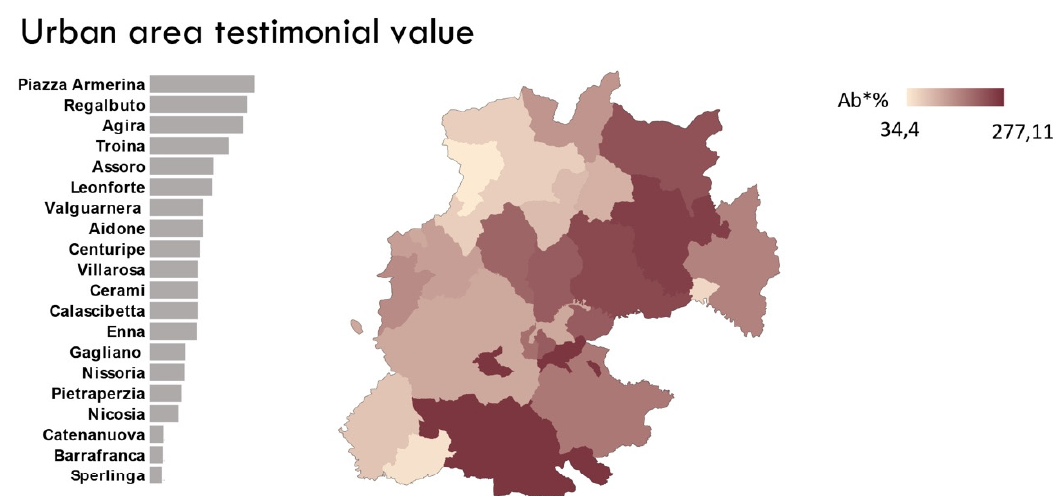
Figure 11. Maps and correlations of Per capita income and Urban area testimonial value in the 20 municipalities (numerical values under the colour ramp).